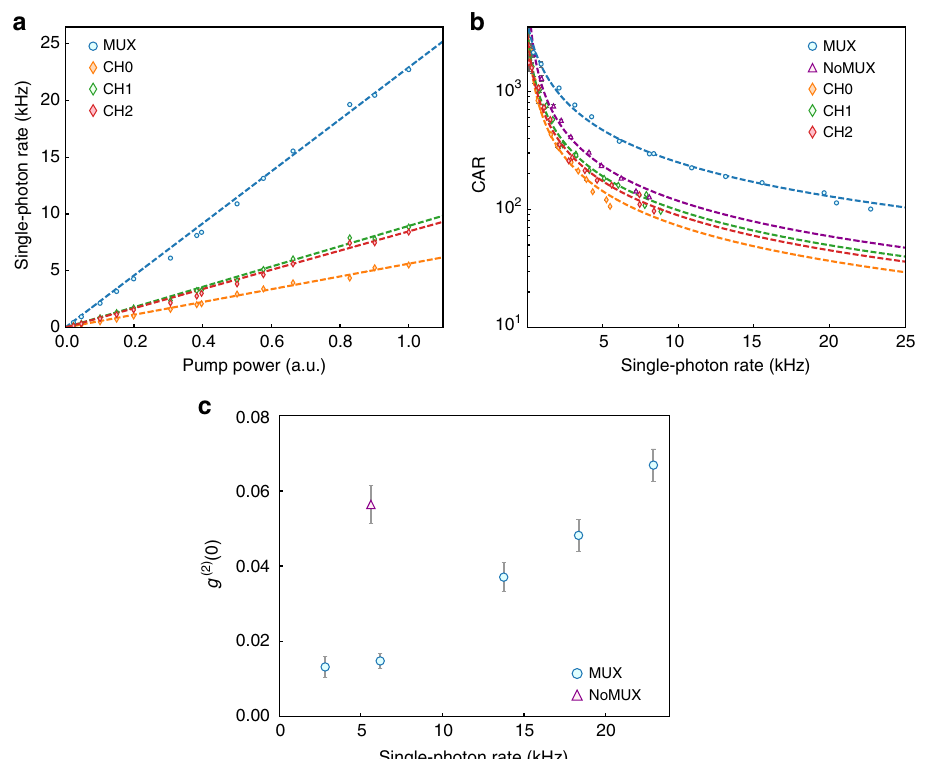
Fig. 4 Experimental results from multiplexing of three frequency modes. Blue circles: multiplexed (MUX) source, purple triangles: NoMUX source, diamonds: contributions from the individual channels (orange — CH0, green — CH1, red — CH2). a Single-photon rate (coincidence counts) as functions of SPDC pump power: The multiplexed source has an enhanced single-photon rate by 4.8 dB as compared to the mean of the individual channels and overcomes the losses of the setup (1.3 dB), with a net enhancement of 220%. At maximum SPDC pump power (25 mW), we measure a single-photon rate of 23 kHz from the multiplexed source. b Coincidences-to-accidentals ratio (CAR) vs single-photon rate: For a fi xed single-photon rate, the multiplexed source has a CAR that is a factor of 2 higher as compared to the NoMUX source. For low count rates, the multiplexed source has a CAR exceeding 1000 and remains high at 100 for large single-photon rates. c Measurement of g (2) (0): the multiplexed source has a low g (2) (0) of 0.07 ± 0.005 for large single- photon rates. For the same single-photon rate of 5.6 kHz the multiplexed source has an improved single-photon purity with g (2) (0) of 0.015 ± 0.002 as compared to the NoMUX source with a g (2) (0) of 0.056 ± 0.005. Error bars are estimated using Poisson